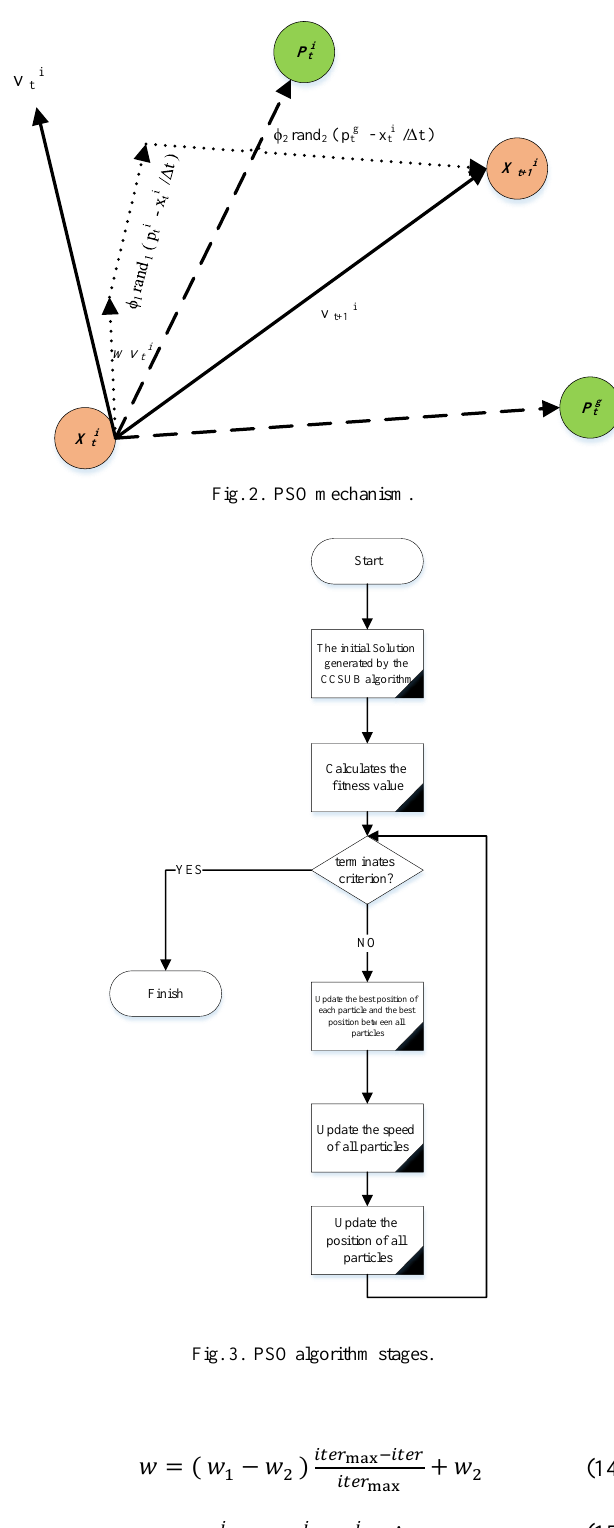
Fig. 2. PSO mechanism.